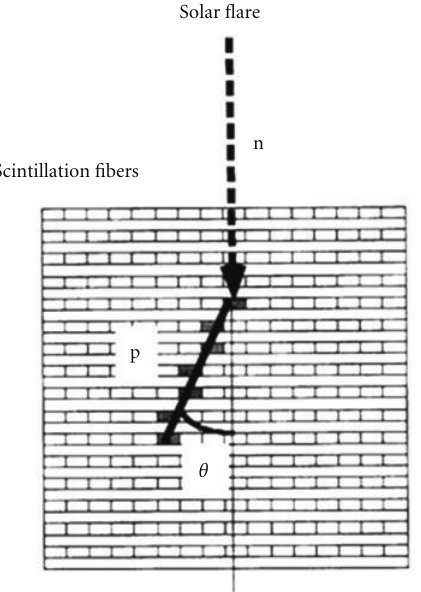
Figure 2: Schematic view of the FIB detector’s sensor. One layer consists of 16 plastic scintillator bars with dimensions of 3mm (height) × 6mm (width) × 96 mm (length). The direction of the Sun is identified by tracking two layers of the scintillator in both x and y directions; the energy of neutrons is measured by the range of